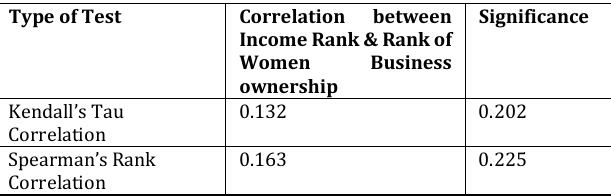
Table 2: Result of Rank Correlation Type of